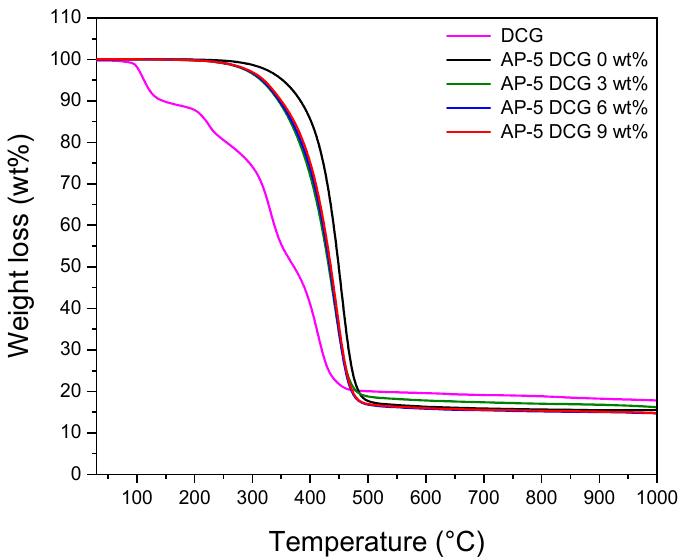
Figure 16. TGA thermograms of DCG, base AP-5 asphalt, and its specimens containing various frac- tions of DCG (e.g., 3, 6, 9 wt%).